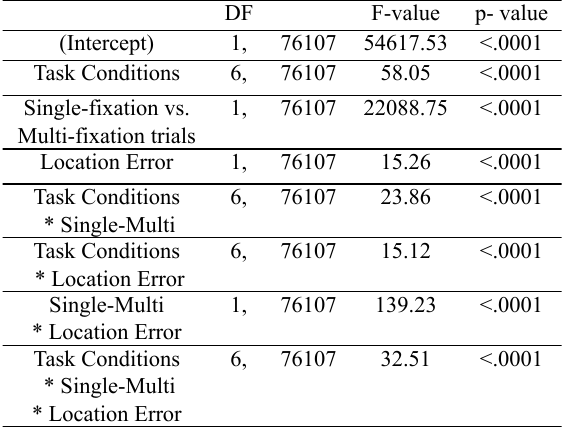
Table 1. Fitting results of the LME